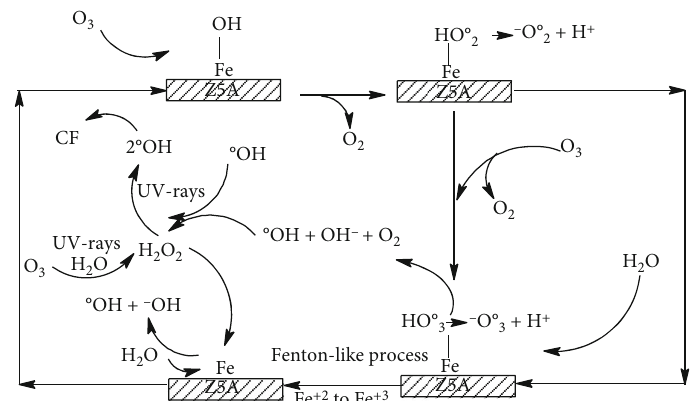
Figure 12: Mechanism of UV-assisted catalytic ozonation on